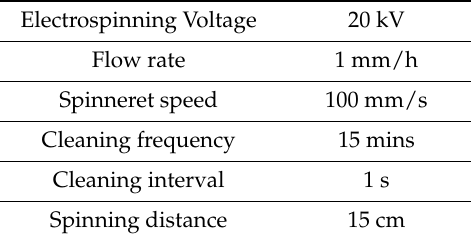
Table 2. Electrospinning condition for preparation of PVDF membrane.